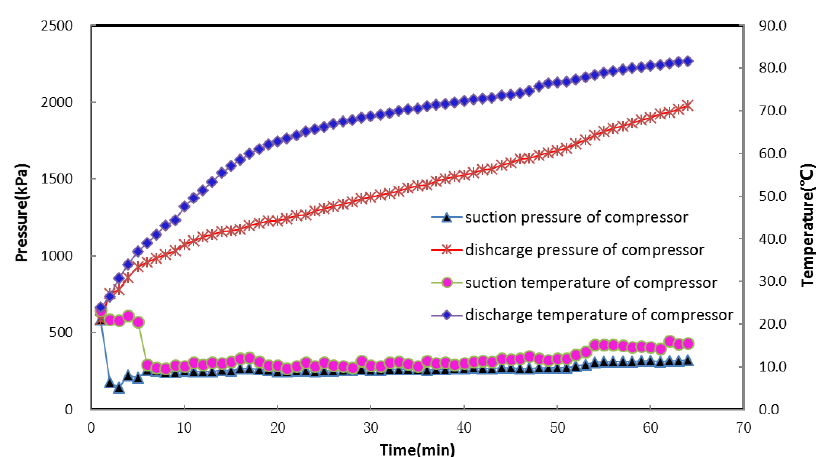
Figure 2. Variations of water temperature with heating time.